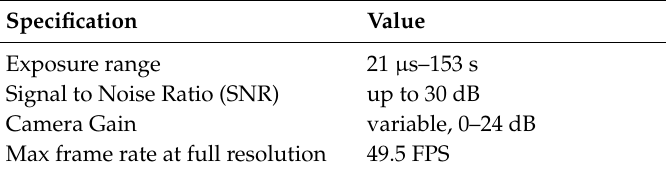
Table 3. Imaging device properties.